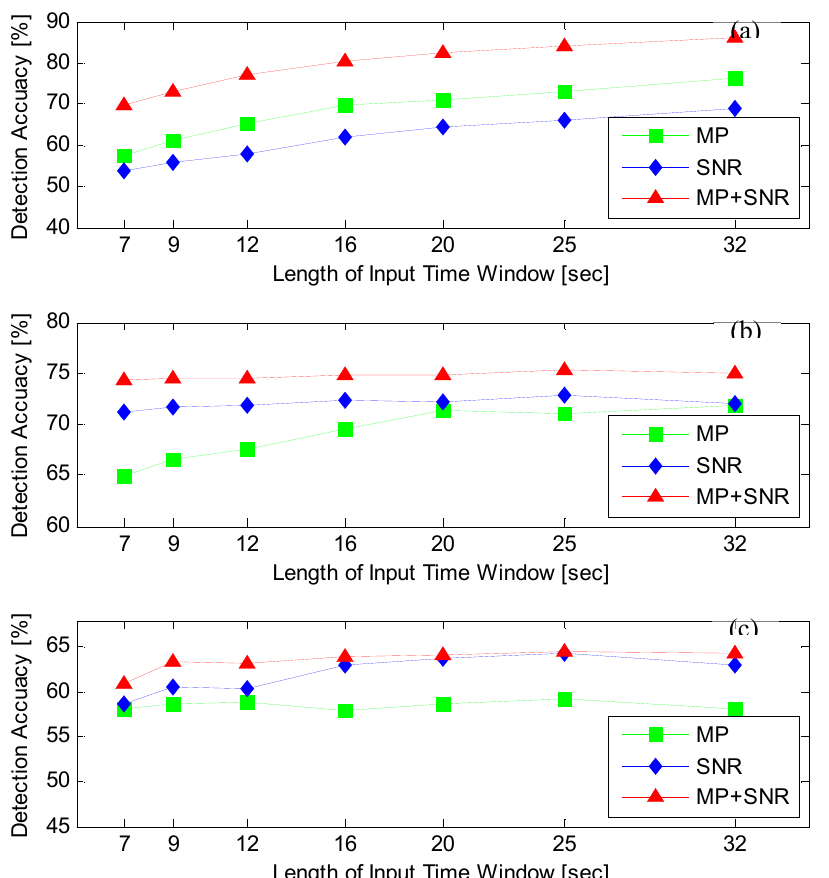
Figure 8. Detection results using feature of MP, SNR and their combination when changing the length of input time window with Dataset SIMTU ( a ); STU ( b ); and KTU ( c ).